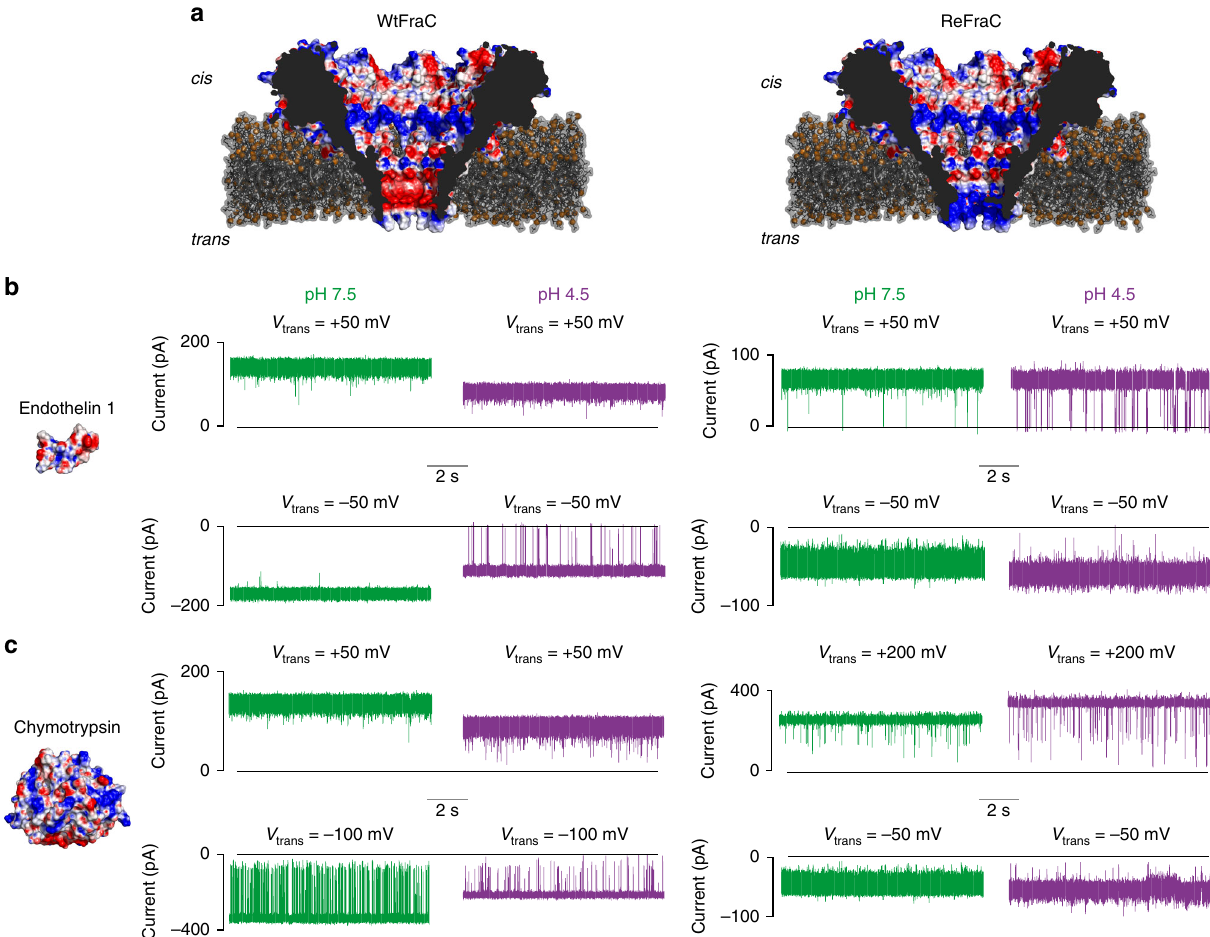
Fig. 1 Capture of endothelin 1 and chymotrypsin with two FraC variants at two different pH conditions. a Cross sections of wild-type FraC (WtFraC, PDB: 4TSY) and D10R-K159E-FraC (ReFraC). b , c Representative traces induced by 1 µ M endothelin 1 ( b ) and 200 nM chymotrypsin ( c ) to WtFraC (left) and ReFraC (right). Chymotrypsin (PDB: 5CHA) and human endothelin 1 (PDB: 1EDN) are shown as surface representations. Endothelin 1 and